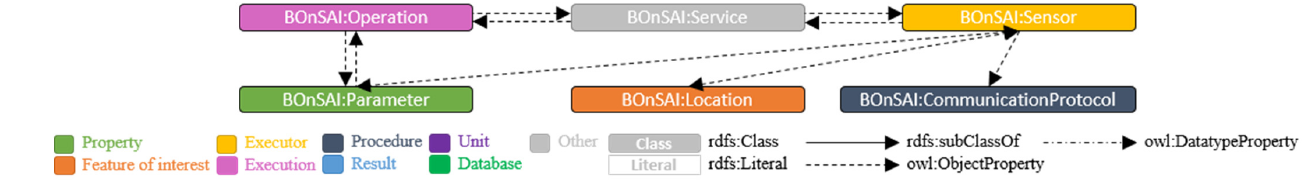
Figure 16. Dynamic properties in BOnSAI.